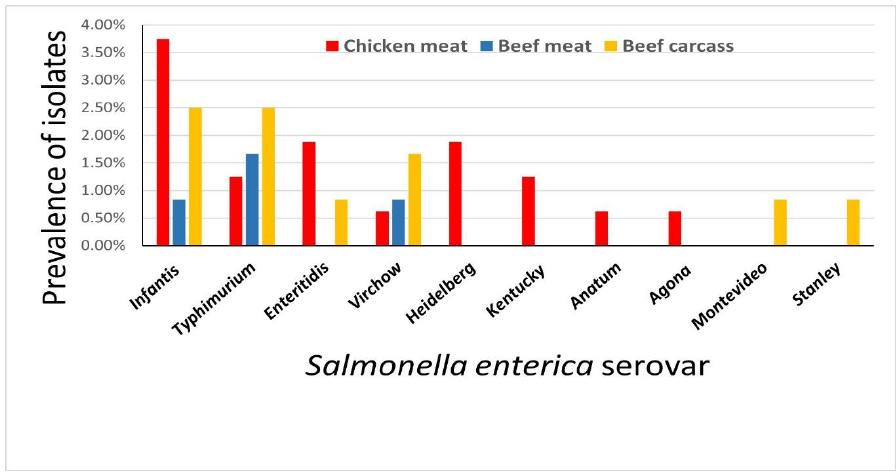
Figure 1. Prevalence of different Salmonella enterica serovars isolated from retail chicken meat, beef meat, and beef carcasses in Egypt.